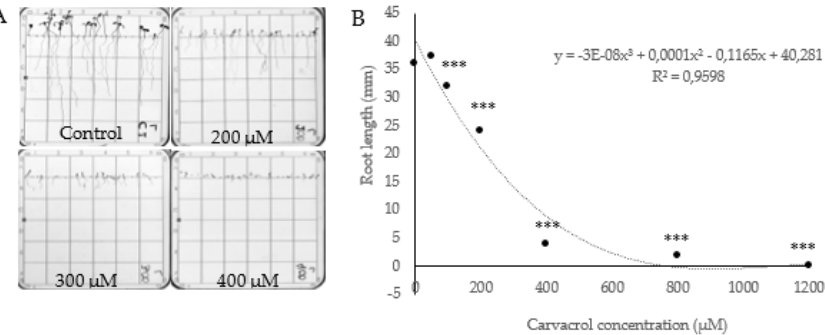
Figure 10. ( A ) Scanned images of Arabidopsis thaliana seedlings treated with 0, 200, 300 and 400 µ M carvacrol ( B ) Dose–response curve of radicle length of Arabidopsis thaliana seedlings after 14 d of carvacrol treatment (0, 100, 200, 400, 800, 1200 µ M). Points marked with asterisks are significantly di ff erent from the control ( p ≤